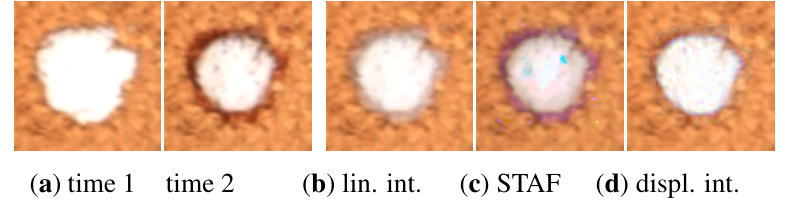
( a ) time 1 time 2 ( b ) lin. int. ( c ) STAF ( d ) displ.